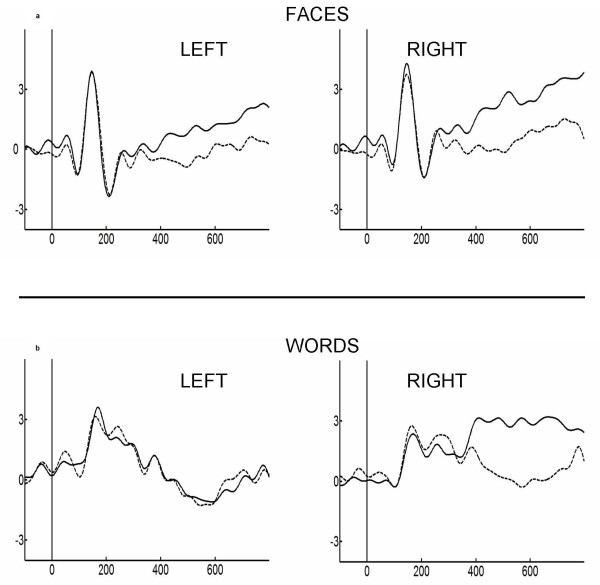
Frontal LPP. Selected ROIs of LPP elicited by faces and words in response to Incompatible (continuous line) and Compatible tasks (dashed line). Top: ERPs of Faces. Bottom: ERPs of Words. In agreement with the behavioral results, we found a LPP modulation related to incompatible blocks. Note the lateralization effects for word stimuli and the bilateral effects for faces.